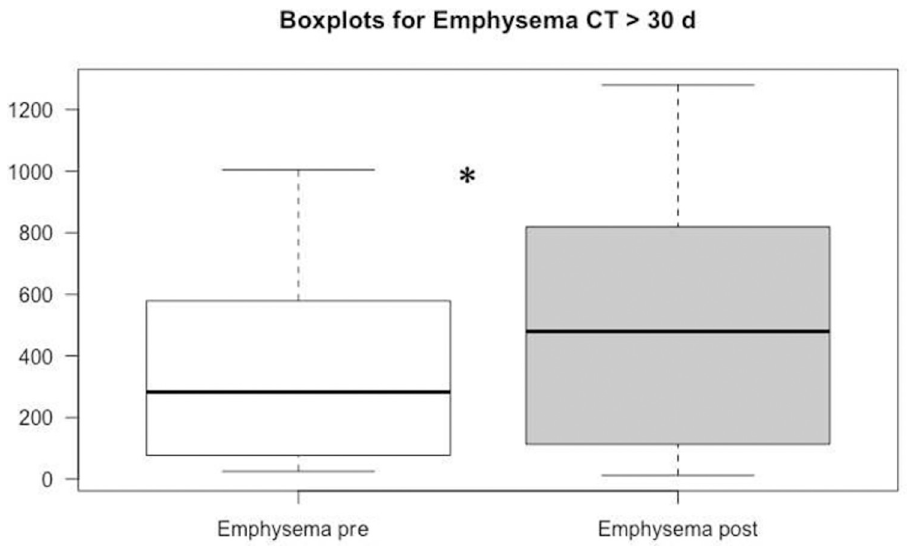
Fig 4. Boxplot for emphysema volume. Automated measured significantly higher amount of emphysema volume in follow-up CT scans > 30 days as compared to the initial CT scan.